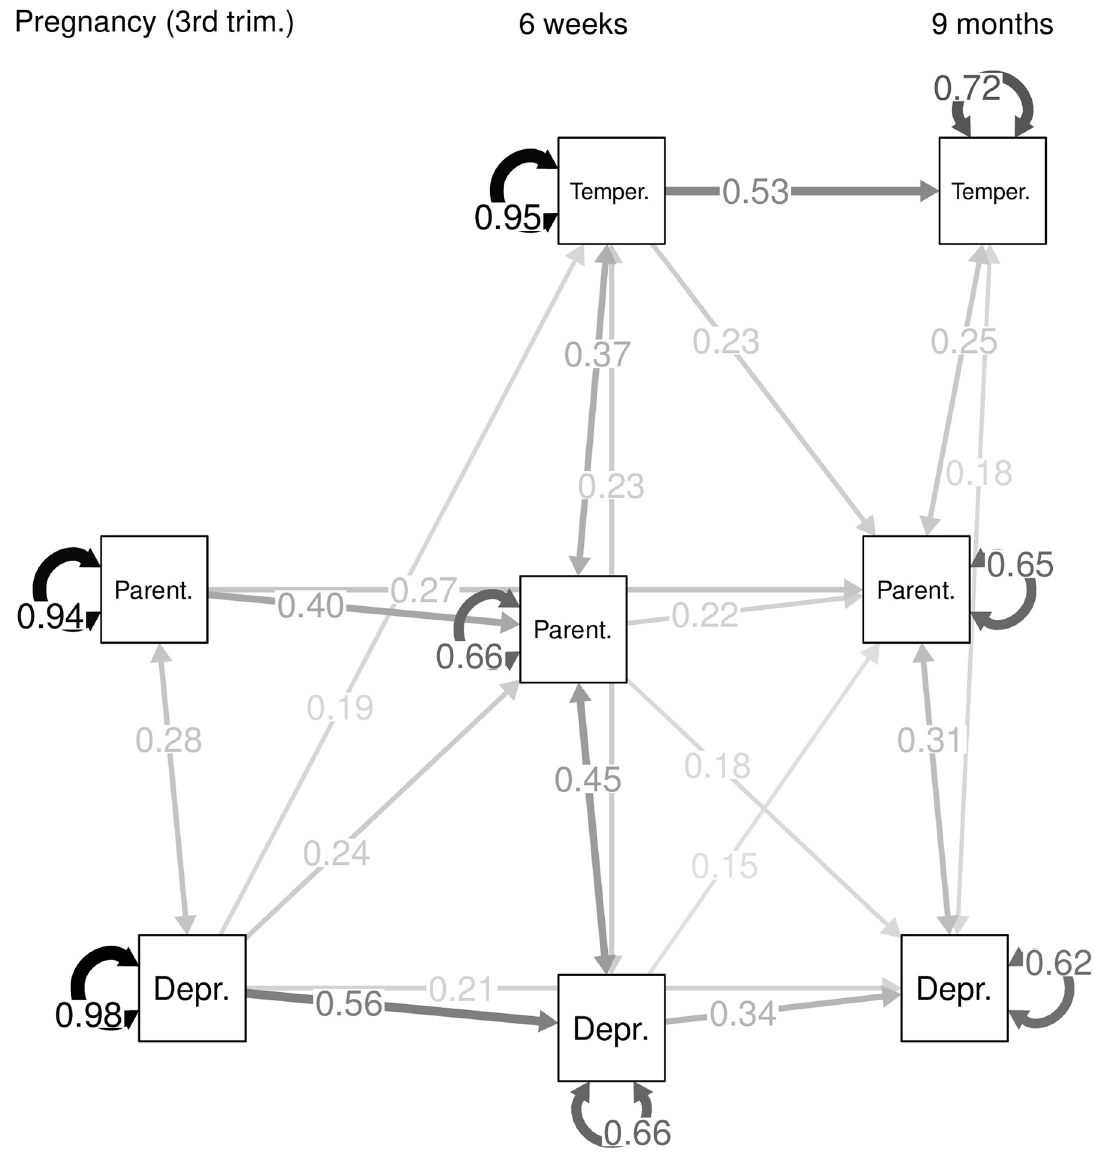
Fig 2. Path diagram of the final